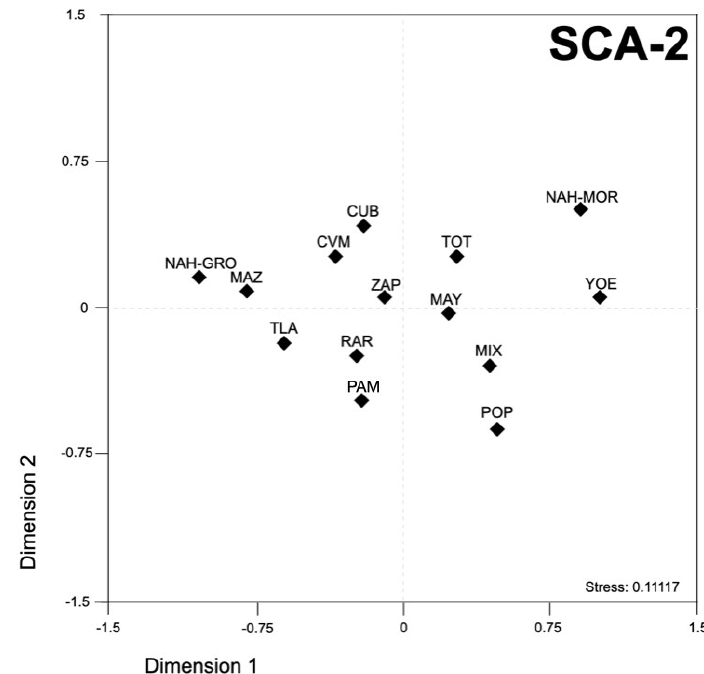
Figure 3. Multidimensional scale plot of R ST values using the SCA2 locus data from Mexican Native American, Mestizos, and Cuban populations. Mayans-MAY; Mazahuas-MAZ; Mixes-MIX; Nahuas- Guerrero-NAH-GRO; Nahuas-Morelos-NAH-MOR; Pames-PAM; Popolucas-POP; Rarámuris (Tarahumaras)-RAR; Yoemem (Yaquis)-YOE; Mexican Mestizos from the Central Valley of Mexico-CMV; Mexican Mestizos from Tlaltetela, Veracruz-TLA; Cuba-CUB. p -values were adjusted with the method of false discovery rates in R-software.